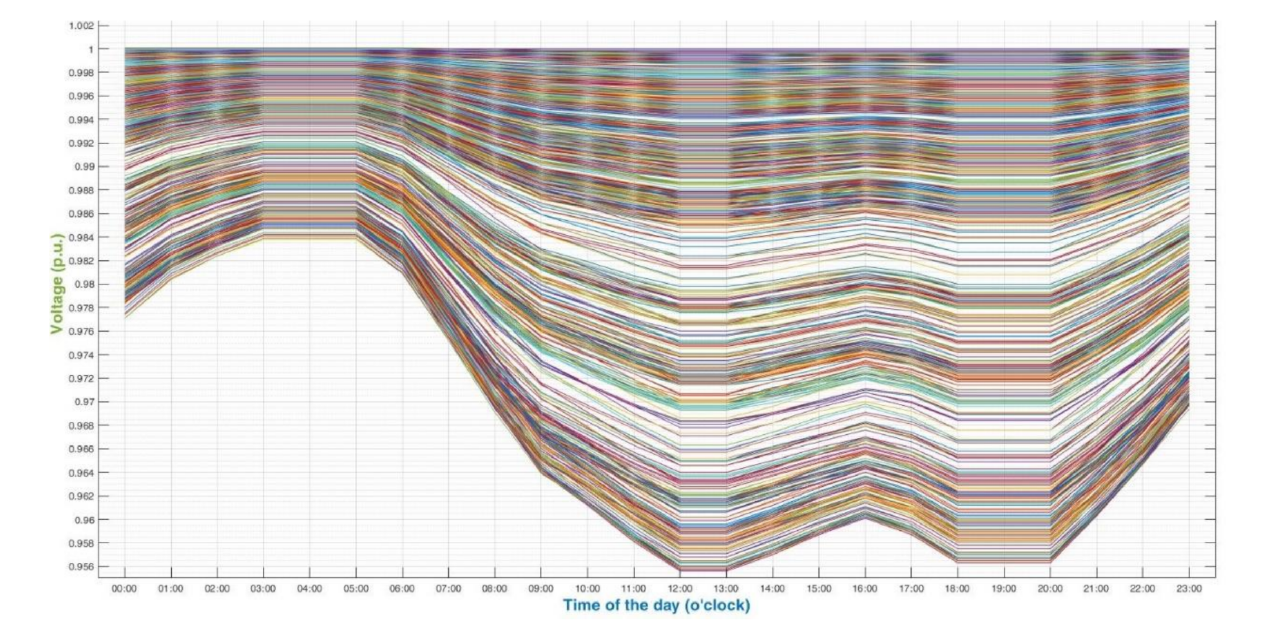
Figure 12. Voltage magnitude per unit of the buses for the LV and MV levels when CS2 (case 1) is applied.